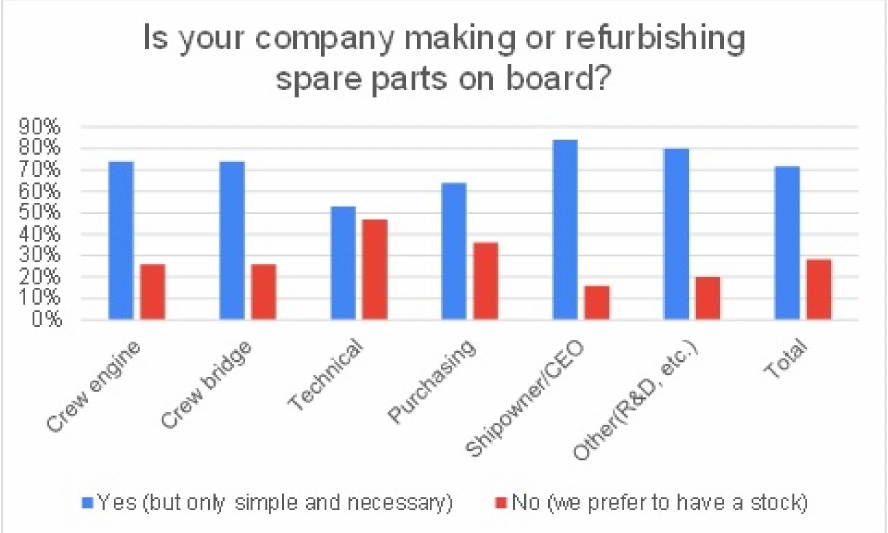
Figure 11. Making or refurbishing spare parts on